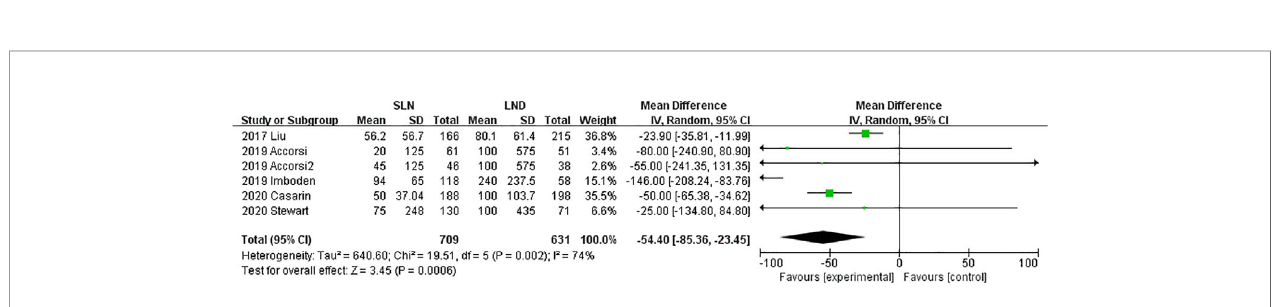
FIGURE 2 | Meta-analysis of blood loss.